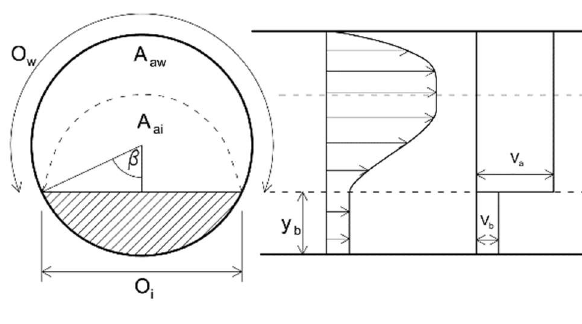
Fig. 4. Schematic of the two-layer model approach